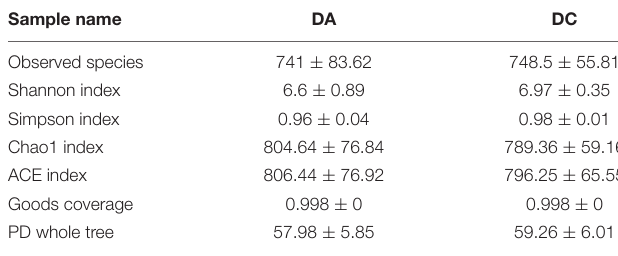
TABLE 1 | The alpha diversity results of different grouped